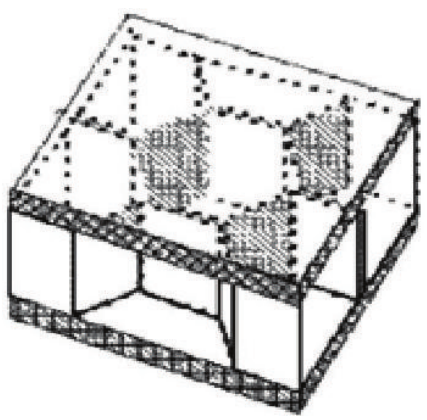
Figure 6: Cell unit of